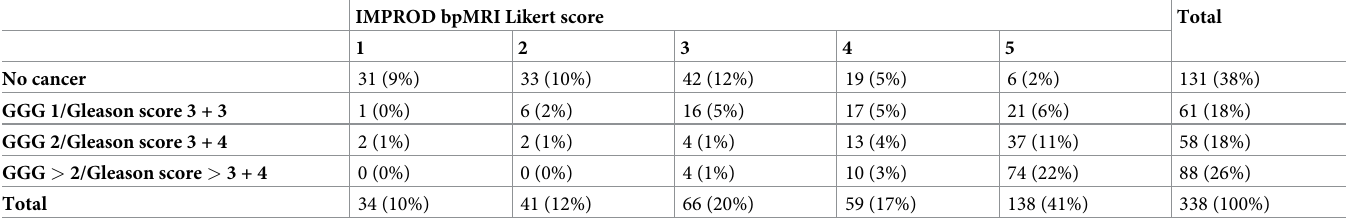
Table 2. Prevalence of prostate cancer and clinically significant prostate cancer in different IMPROD bpMRI Likert score groups based on a cohort of 338 men. IMPROD bpMRI Likert score